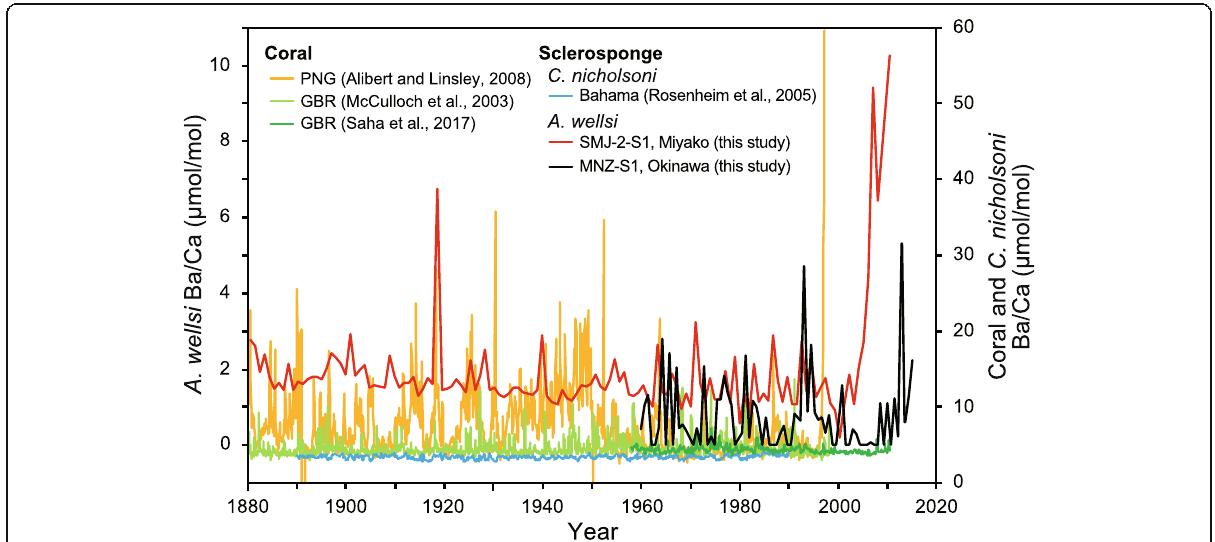
Fig. 9 Secular Ba/Ca variations in sclerosponges and corals from the Pacific and Atlantic